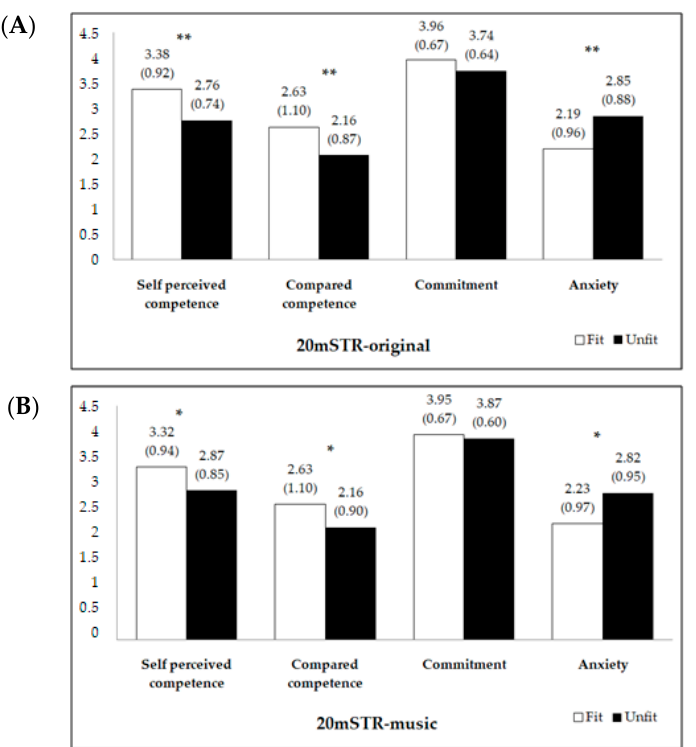
Figure 1. Motivation levels between fit and unfit adolescents using the original 20 m shuttle run test (20mSRT-original, panel ( A )) and the adapted 20 m shuttle run test with music (20mSRT-music, panel ( B )). The difference between fitness groups (fit vs. unfit) was calculated using analysis of covariance, adjusting for age, gender, and body mass index. * p <0.05 ** p < 0.001.